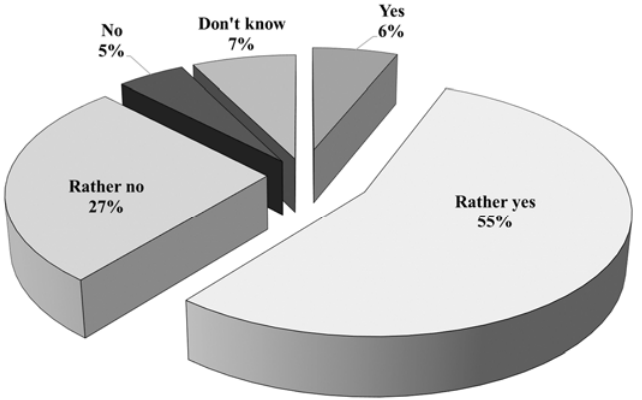
Figure 5. Respondents’ answers regarding the correlation between the price and the quality of power banks offered on the market.